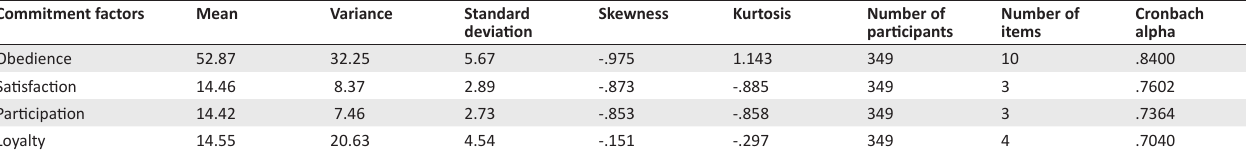
TABLE 3: Descriptive statistics and reliability analysis in respect of employee commitment. Commitment factors Mean Variance Standard deviation